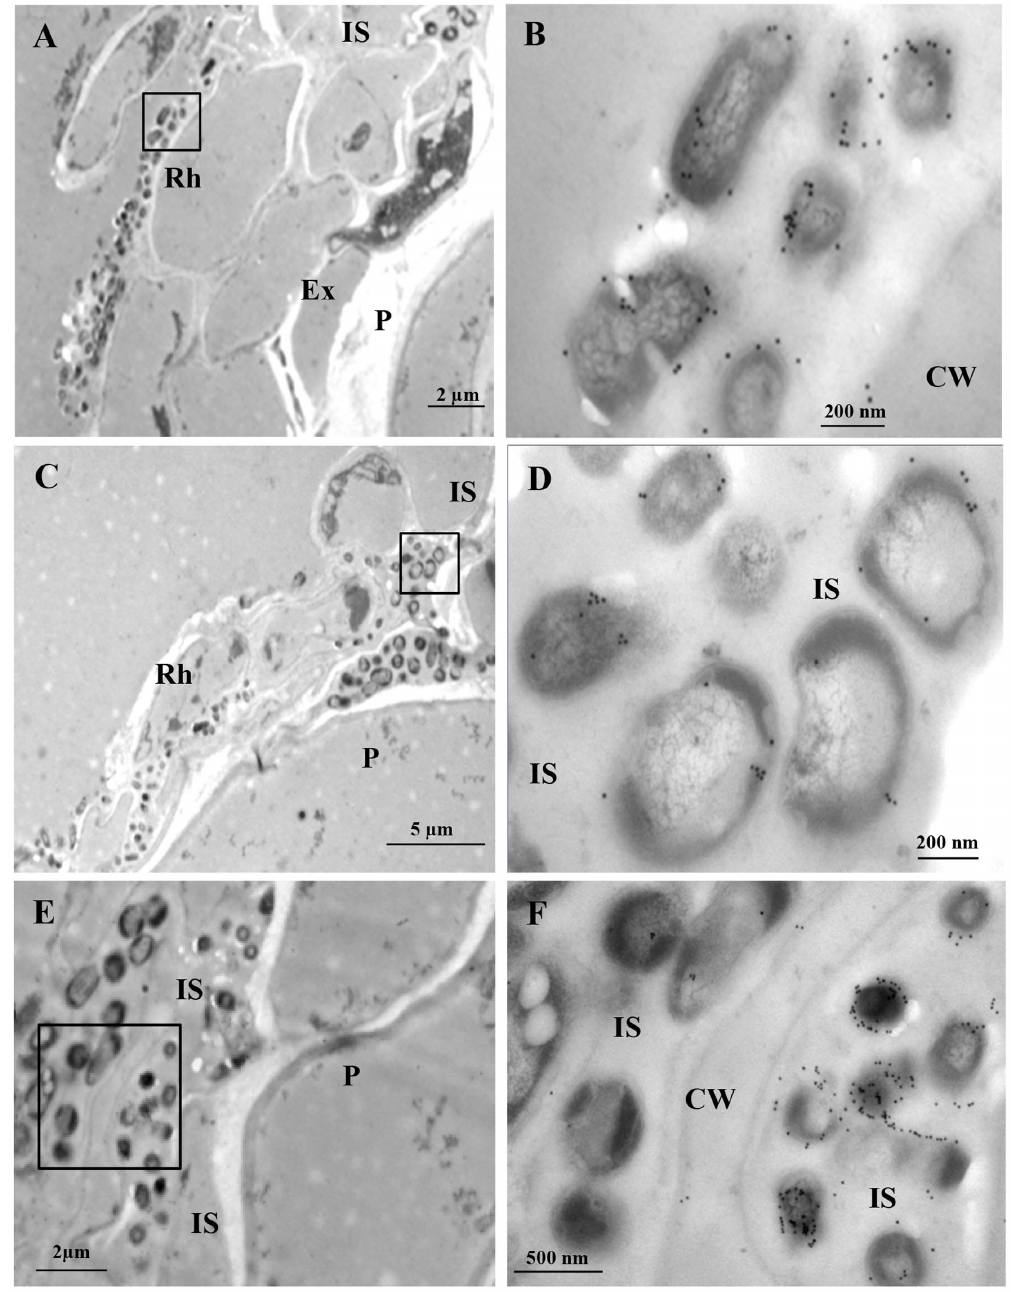
Figure 7. Electron microscopy observation of rice roots colonized by Azoarcus sp. CIB. Electron micrographs showing immunogold localization of NifH epitopes in rice roots inoculated with Azoarcus sp. CIB (pSEVA23GFP) cells for 7 days. Surface colonization (A), intercellular colonization of the second and third layers of the exodermis (C), intercellular colonization of the deeper layer of the exodermis, just in contact with the parenchyma (E). CW, cell wall; Ex, exodermis; IS intercellular space; Rh, rhizodermis; P, parenchyma. In order to distinguish gold particles, the framed areas in A, C and E are magnified in panels B, D and F, respectively.